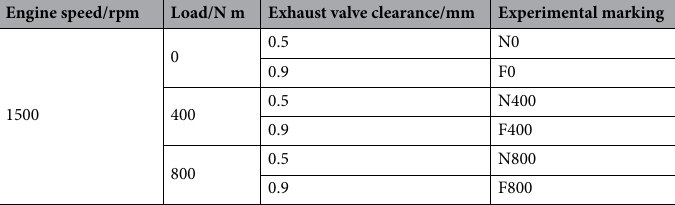
Table 4. Setting of experimental conditions.